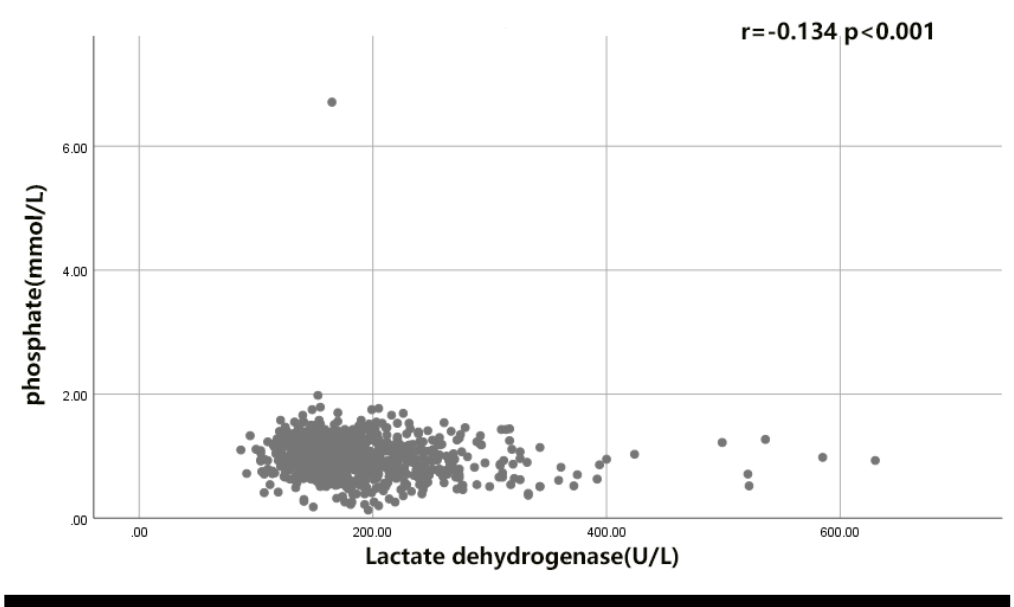
Figure 4. Correlation of serum phosphate with Hunt − Hess grade after intracranial aneurysm rupture.